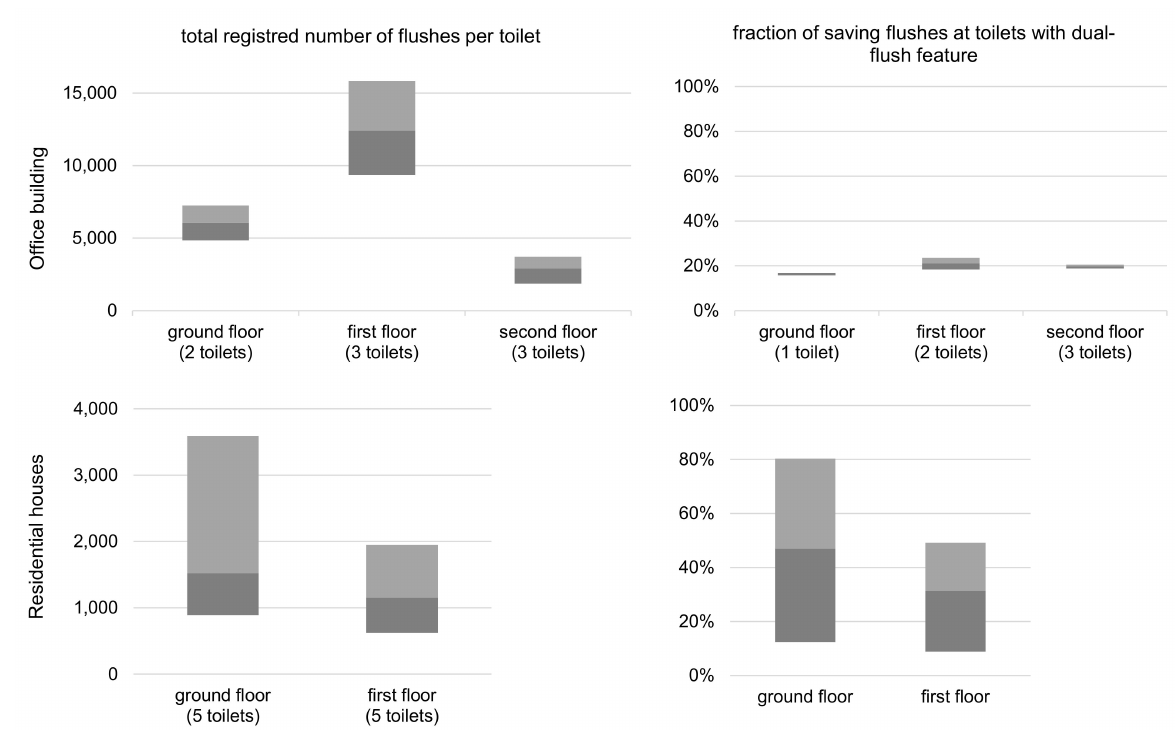
Figure 2. Left: Total number of registered flushes per toilet. The figures include also the two toilets at the office building with only one flushing button. Right: fraction of saving flushes at the toilets with two flushing buttons (dual-flush feature). The upper panels show the data from office building and the lower panel from the residential houses. The bars show the variation between the toilets using minimum, average and maximum for each